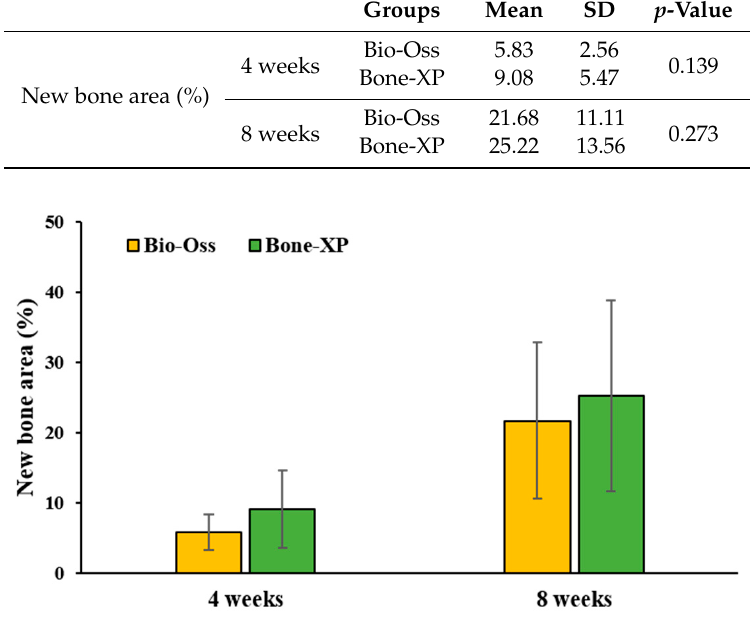
Figure 12. New bone area percentages within area of interest (AOI).